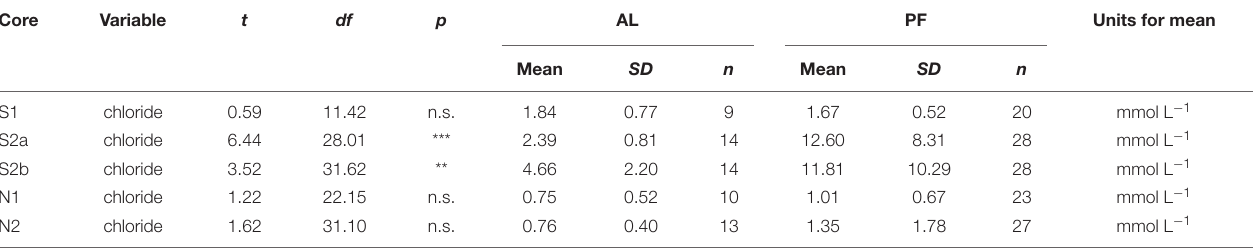
TABLE 7 | Results from Welch’s t -test, which was used to test whether the concentration of chloride was significantly different for permafrost (PF) versus active layer (AL) in each core. Core Variable t df p AL PF Units for mean Mean SD n Mean SD